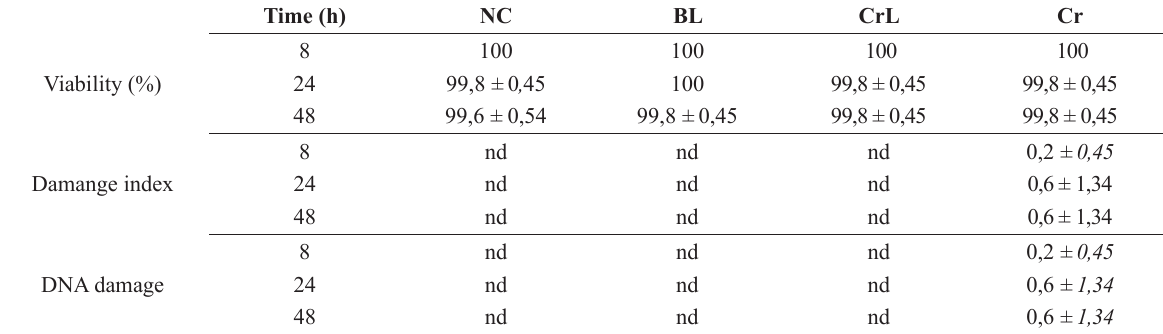
Effect of different treatments with creatine on cell viability and genotoxicity.